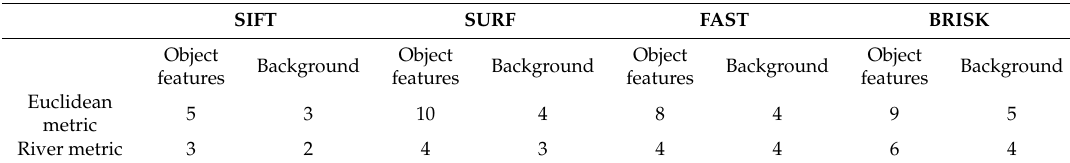
Table 2. Average number of created objects using a key-search algorithm with the connection with Euclidean or river metrics. SIFT, scale-invariant feature transform; SURF, speeded up robust features; FAST, features from accelerated segment test; BRISK, binary robust invariant scalable